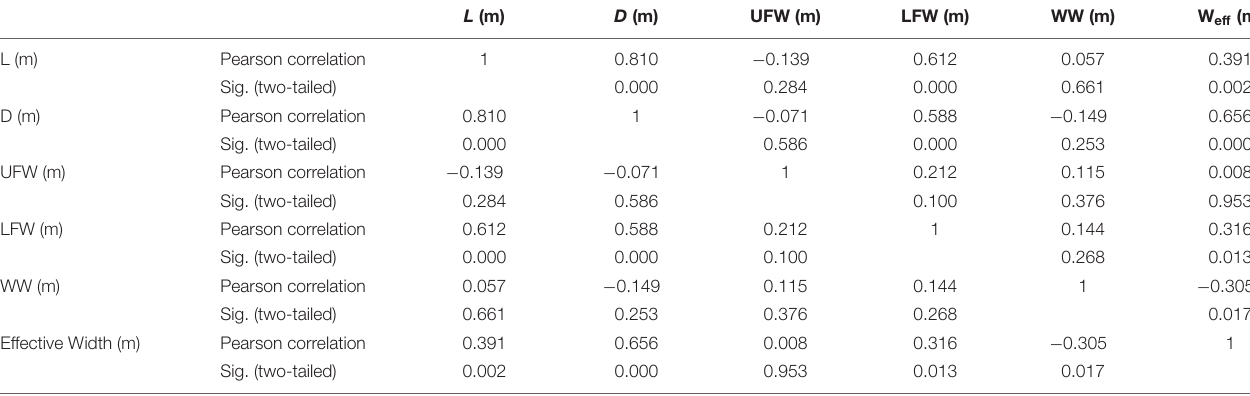
TABLE 3 | Correlations between the dataset’s dimensional variables.